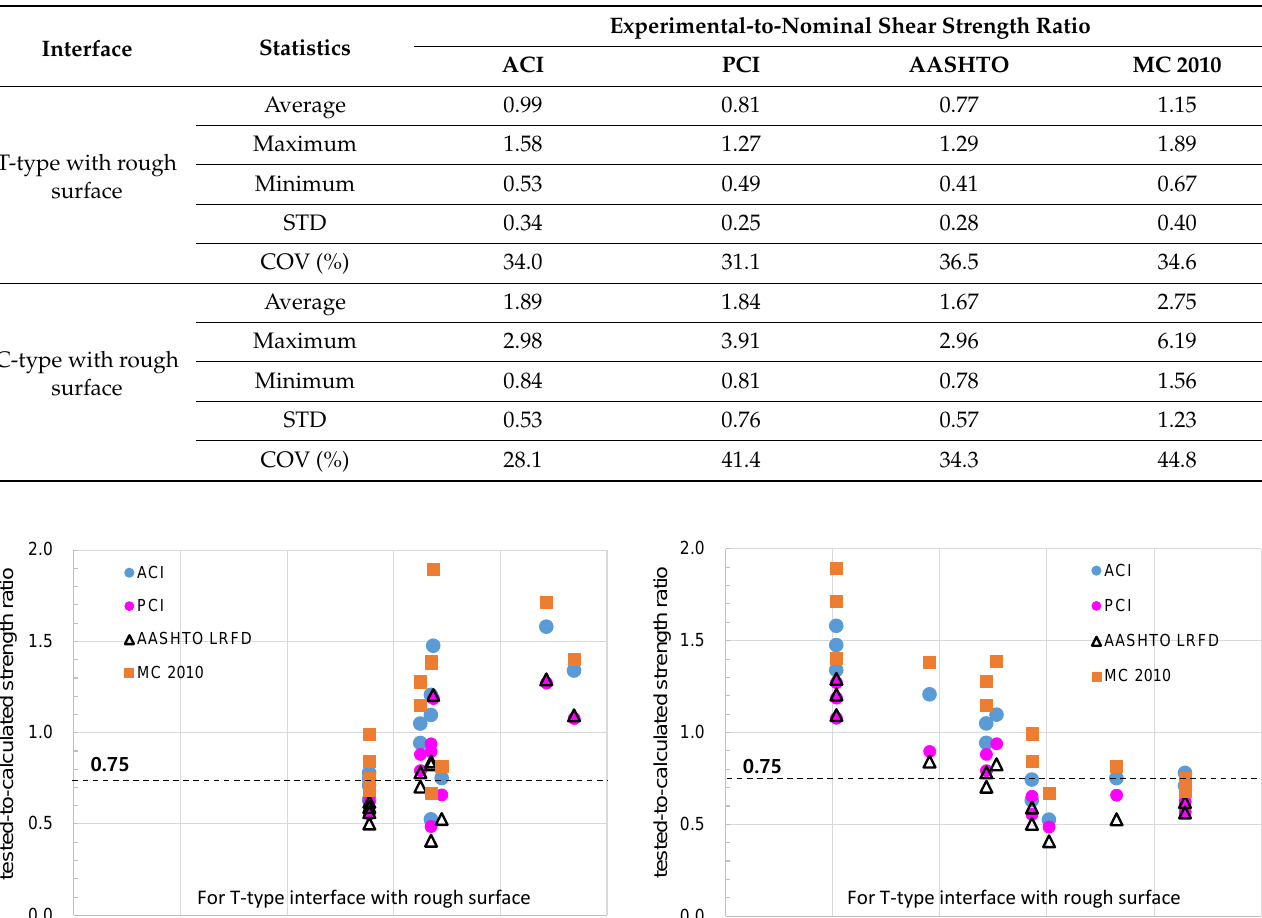
Table 7. Statistical analysis of design provisions depending on the interface location.